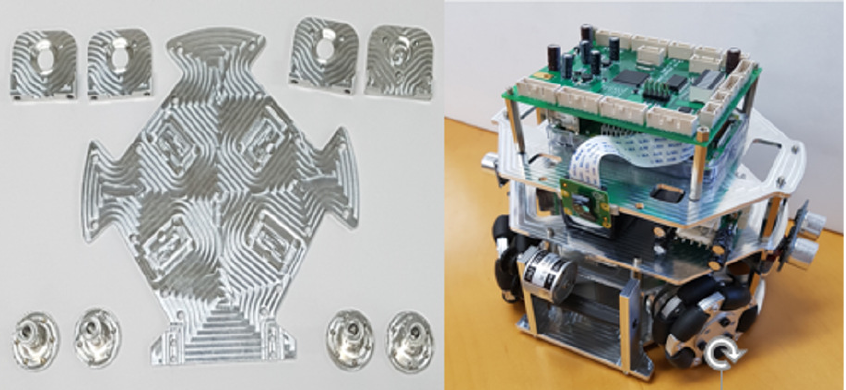
Figure 3. Mechatronics hardware configuration: component of body plate, the assembly of the onboard robotic platform.